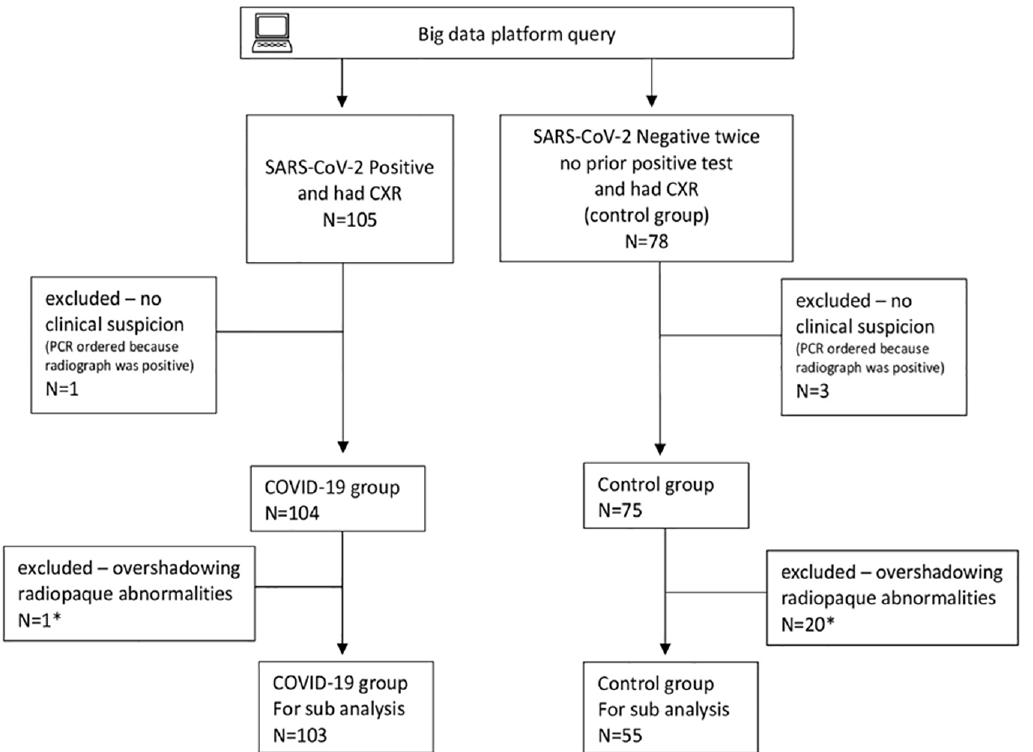
Figure 1. Study selection process flowchart. *Overshadowing radiopaque abnormalities excluded from the subgroup analyses were pleural effusion (n = 1 COVID-19, n = 17 control), lung cancer (n = 1, control), lung metastasis (n = 1, control), and pleural plaques (n = 1,